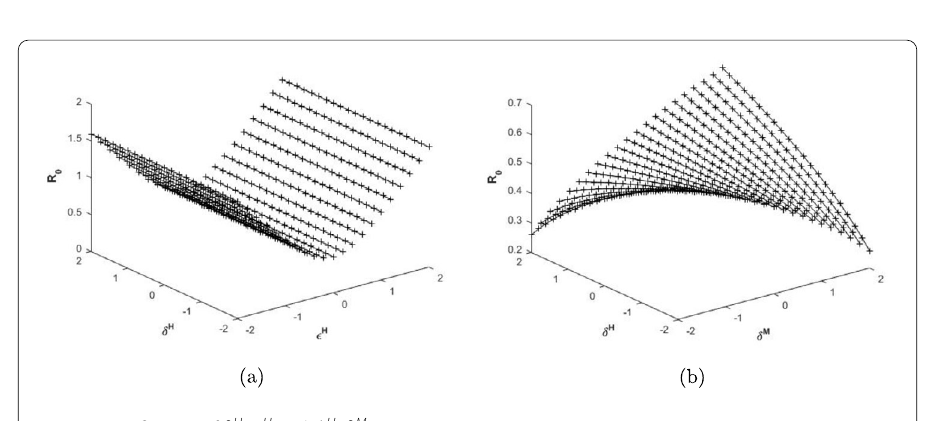
Figure 11 Influence of δ H , (cid:6) H and φ H , δ M on R 0